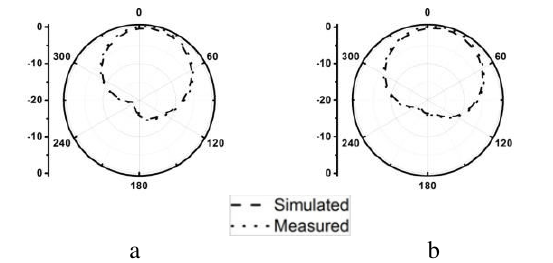
12: Simulated and measured radiation characteristics of the proposed antenna at 3.2 GHz a E plane b H